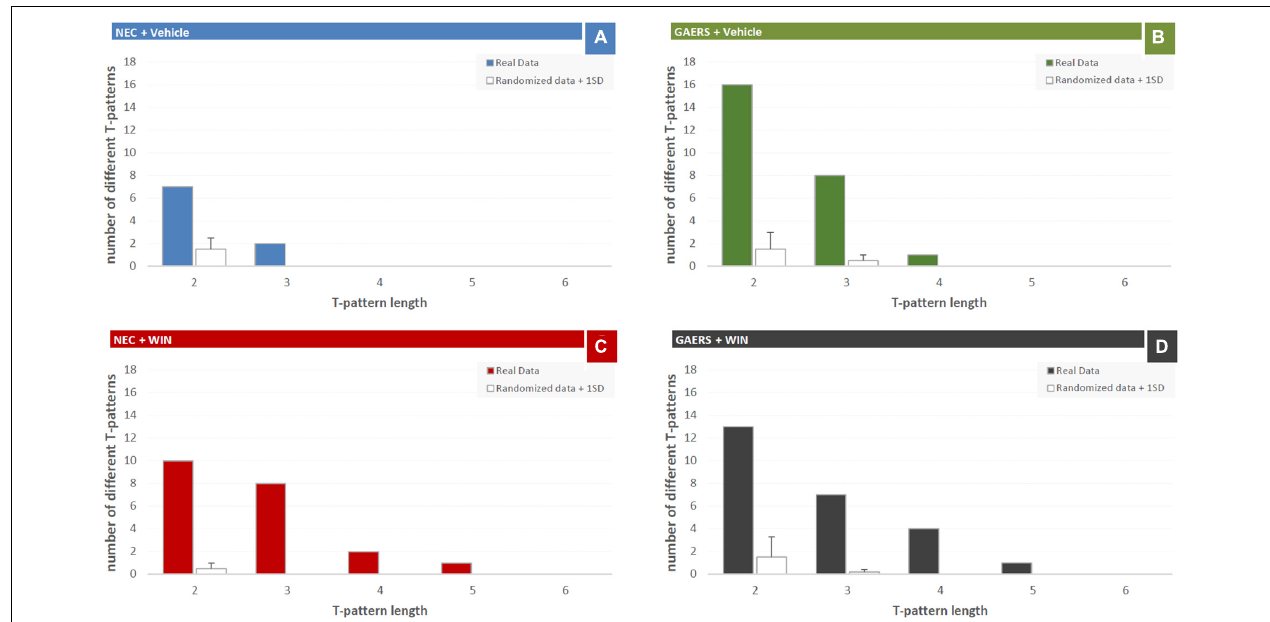
FIGURE 4 | Effect of WIN 55,212-2 and its vehicle on the temporal patterns (T-patterns) in GAERS and NEC rats. Administration of WIN 55,212-2 (WIN; 2 mg/kg, IP ) and its vehicle affected the T-pattern of behaviors detected in GAERS and NEC rats during the 10 min of the hole-board test. Numbers on the right of each string indicate their overall length and occurrences (Occs). Behavioral events in brackets do represent the textual representations of T-patterns in terms of order of events (by reading each string from left to right). Brackets do indicate hierarchical detections of events within each T-patterns on the basis of bottom-up detection process (see section “Data Analysis” for details). Numbers on the right of each string indicate the number of events (length) and the occurrences (Occs) of each T-pattern. Data were obtained from the analysis of four groups ( n = 15 rats in each group). For abbreviations see text and Supplementary Figure